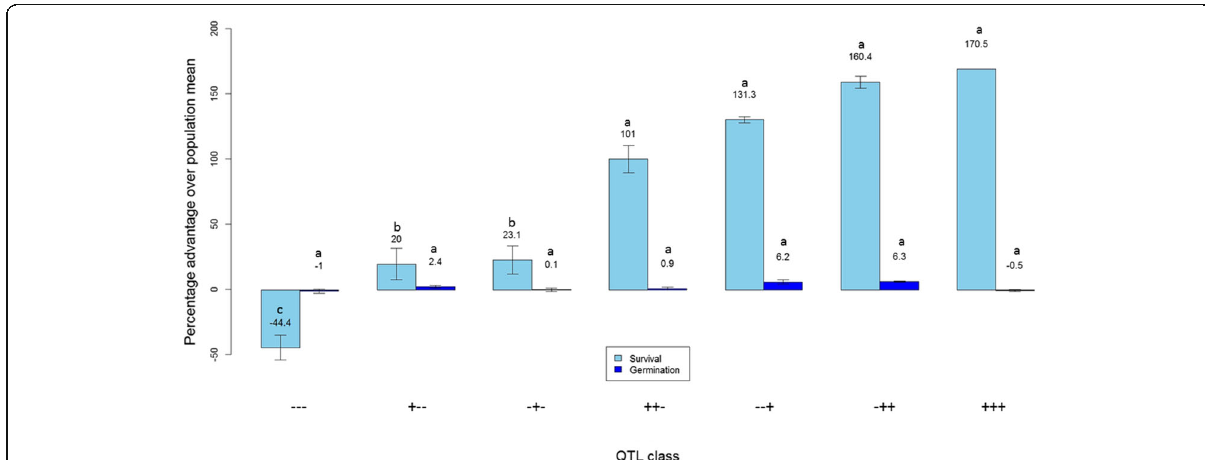
Fig. 4 Effect of combinations of qSUR3 – 1, qSUR6 – 1 , and qSUR7 – 1 on mean seedling survival under anaerobic conditions at 21 days after seeding. --- refers to lines without the three QTLs, + − - refers to lines with qSUR3 – 1 , − + − refers to lines with qSUR6 – 1 , ++ − refers to lines with qSUR3 – 1 and qSUR6 – 1 , −− + refers to lines with qSUR7 – 1 , − ++ refers to lines with qSUR6 – 1 and qSUR7 – 1 , and +++ refers to lines with all three QTLs. Letters ( “ a ” , “ b ” and “ c ” ) above the mean values represent the ranking of each QTL class, where the same letter implies that the mean values are not statistically